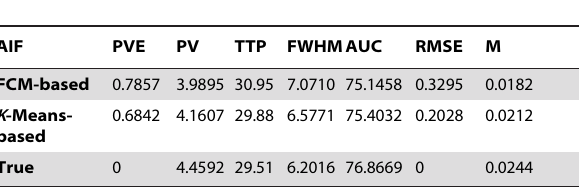
Figure 3. Comparison of the true AIF, K-means-based AIF, and FCM-based AIF.